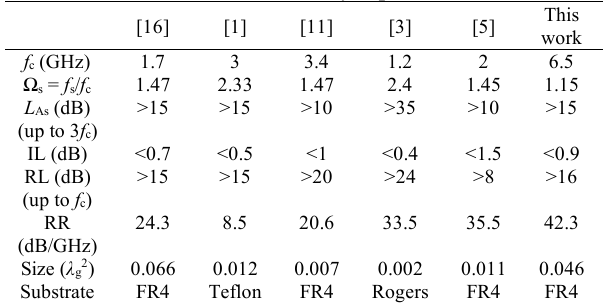
Table 1: Performance comparison of the LUC with other CPW LUCs already